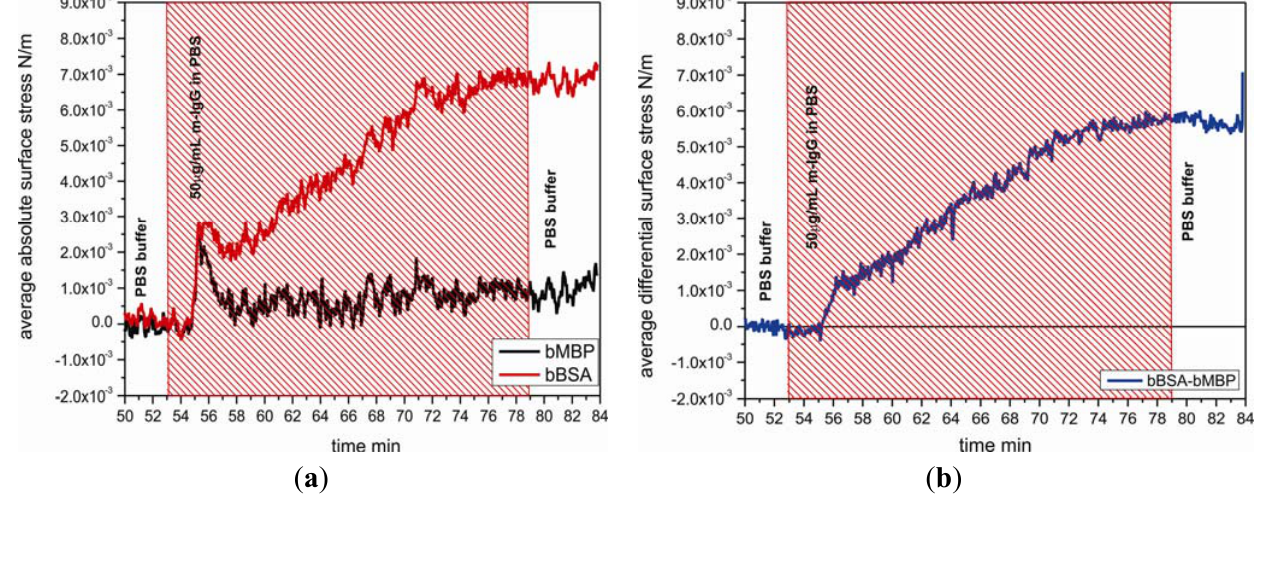
Figure 4. Specificity test of the biotinylated BSA layer on cantilevers to m-IgG. ( a ) The average absolute bending responses of different protein coated cantilevers upon injecting of m-IgG (red hatched area) displaying different binding affinity. ( b ) The average differential bending signal of BSA to m-IgG is evaluated by subtracting of the bending signal of bMBP to